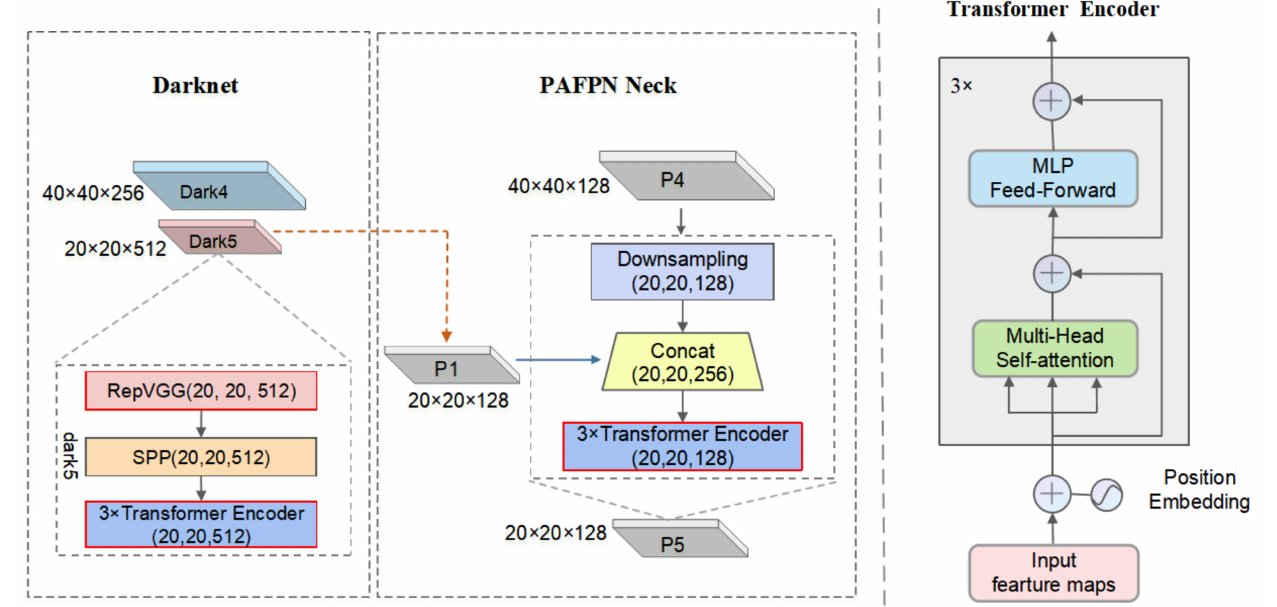
Figure 6. The architecture of the Transformer encoder. It has two sub-layers, a multihead self-attention mechanism, and a multilayer perceptron